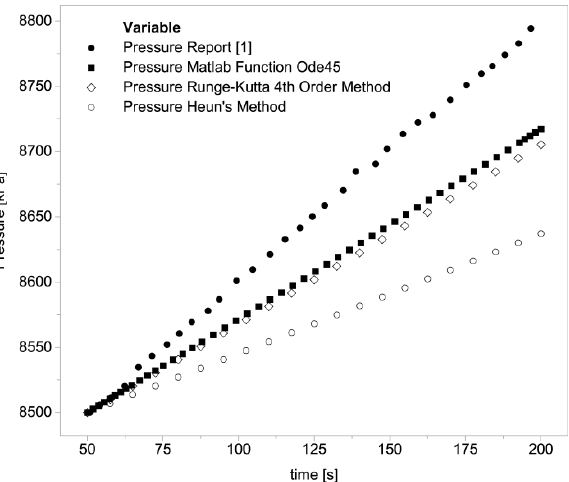
Figure 9. Pressure behavior with different solution methods (Ode45, Runge – Kutta, Heun).